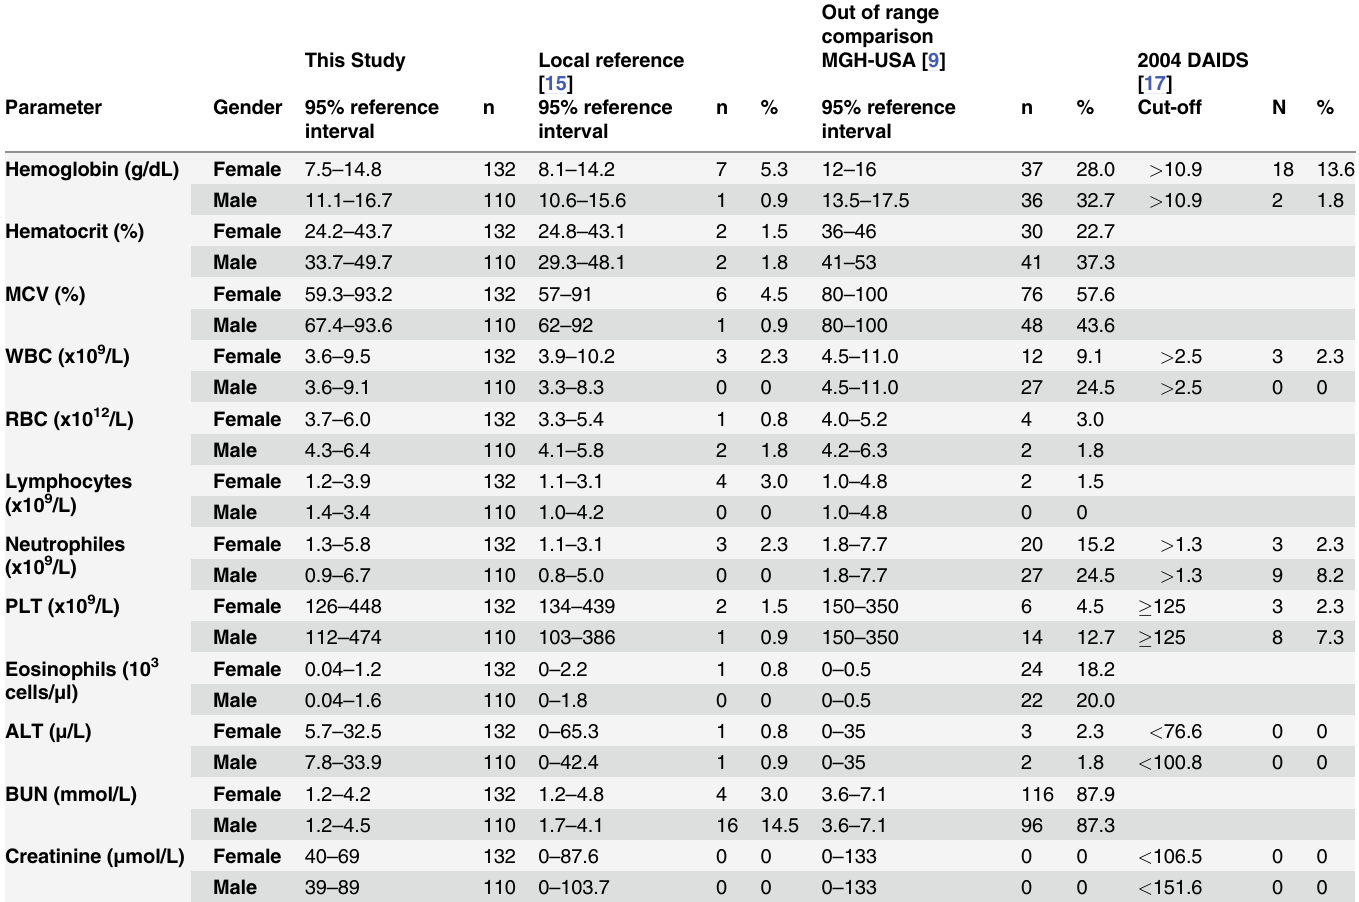
Table 6. Out of range and frequency of adverse events in the Kisumu Adolescent cohort obtained from comparison with values from locally-estab- lished reference intervals and DAIDS